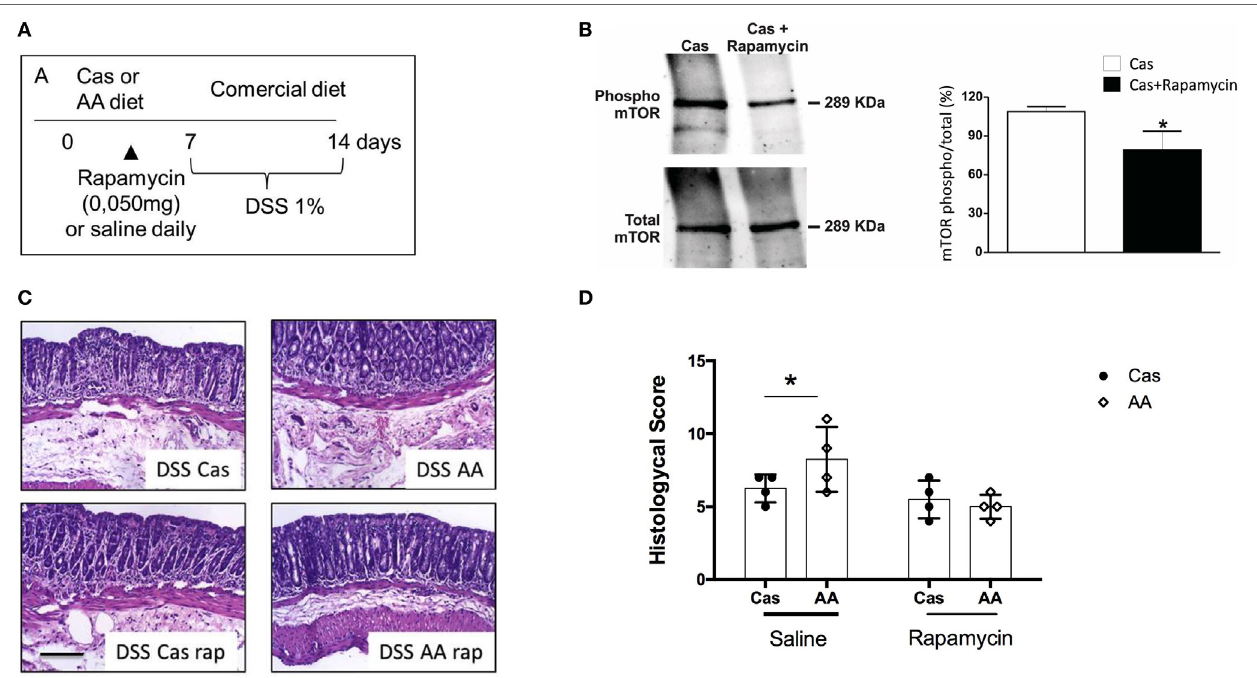
FigUre 7 | Effect of rapamycin administration during experimental diet consumption in colitis induction. (a) C57BL/6 mice at 7–8 weeks of age received either casein-containing diet (CAS) diet or diet containing free amino acids (AA diet) and a daily intraperitoneal (i.p.) dose of 10 mg/ml rapamycin for 7 days. Then, experimental diets were replaced by commercial mouse chow and colitis was induced by administration of 1% dextran sodium sulfate (DSS) for 7 days. During colitis development, mice received commercial chow. Expression levels of total and phosphorylated (pmTor) in colon samples of CAS-fed mice treated or not with rapamycin were analyzed by Western blotting (b) . Histological scores (D) were evaluated after colitis induction and representative images are shown (c) . Statistical analysis was performed between CAS-fed and AA-fed group at the end of each experimental time point using Student’s t test for parametric data and Mann– Whitney test for non-parametric data. p <